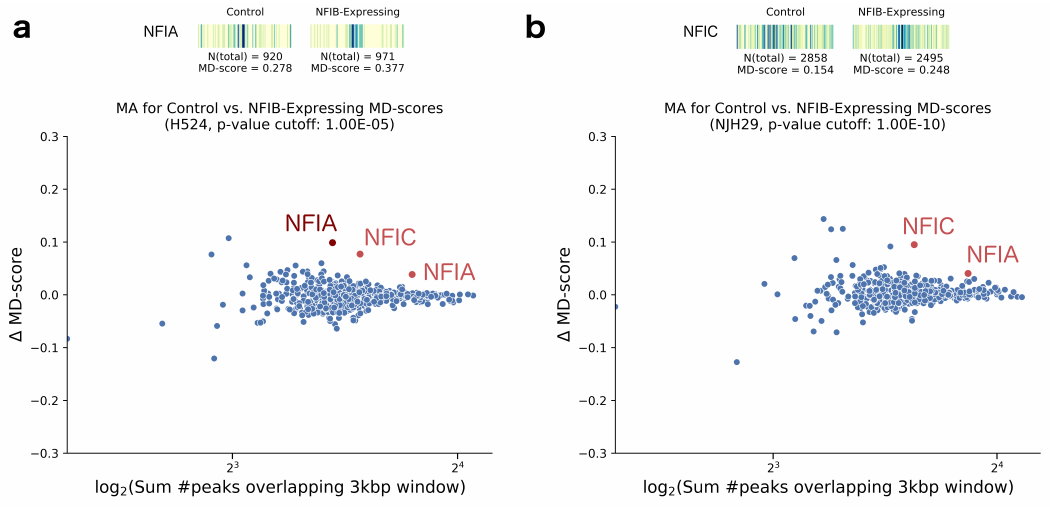
Figure 2. ( a ) Top: Motif displacement distribution as heatmap (increasingly dark blue indicates more instances of motif), MD-score and the number of motifs within 1.5 kb of an ATAC-seq peak in control and NFIB-induced H524 cells with doxycycline, for the upregulated TF NFIA. Bottom: For all motif models (each dot), the change in MD-score following perturbation (y-axis) relative to the number of motifs within 1.5 kb of any ATAC-seq peak center (x-axis). Red/maroon points indicate significantly increased MD-scores ( p -value <10 − 5 and <10 − 4 , respectively). ( b ) Equivalent analysis performed on NJH29 cells, displaying a motif displacement distribution of the NFIC TF upregulation. We note that, in the doxycycline-treated cells, most ATAC-seq peaks are located closer to the motif center than on the control